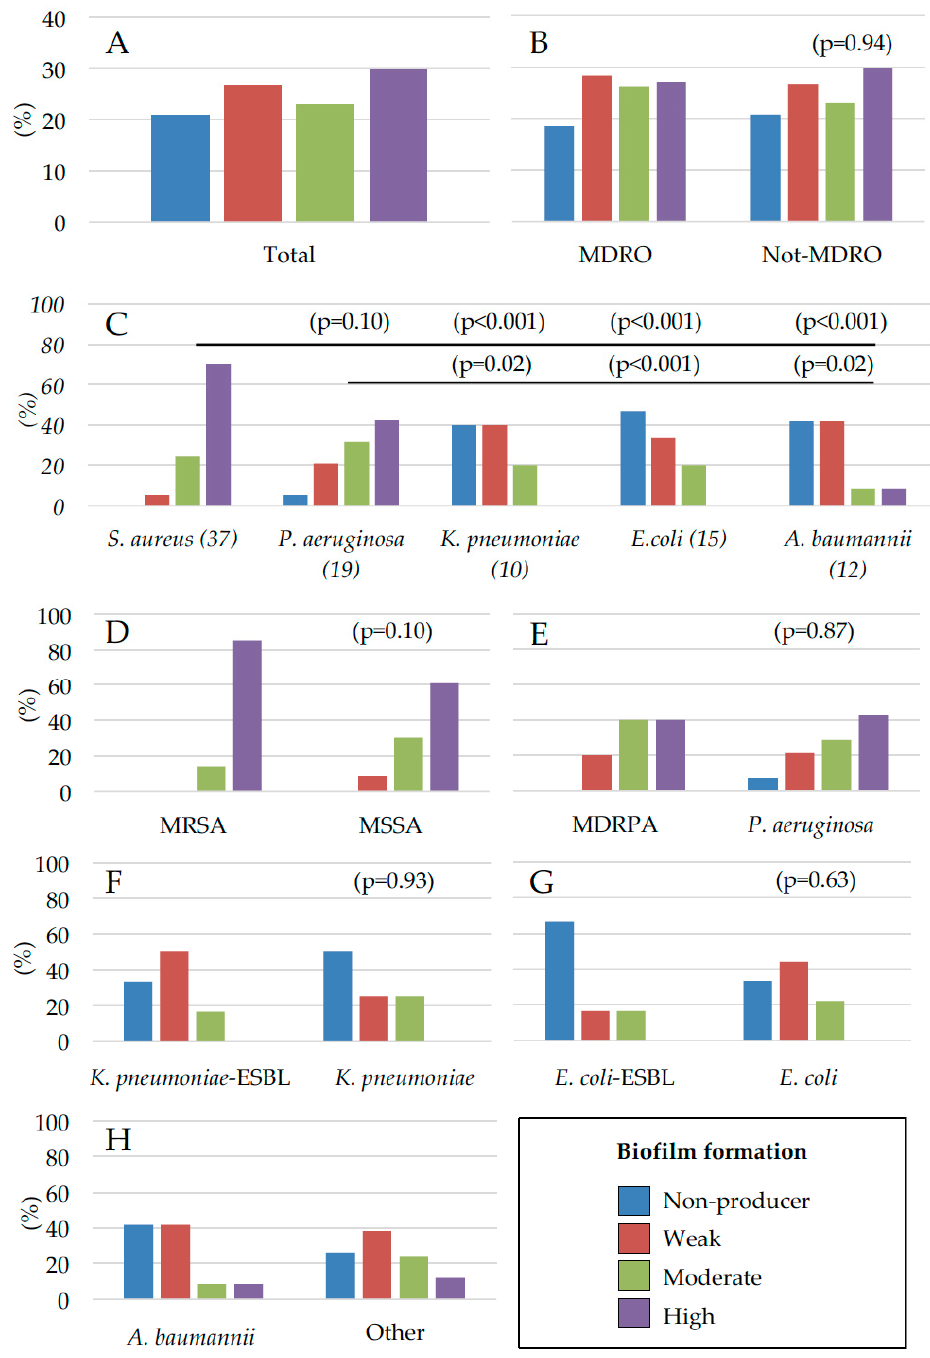
Figure 3. Biofilm production of bacterial isolates from patients with chronic skin ulcers. ( A ) biofilm production of the total bacterial isolates; ( B ) of MDRO and not-MDRO; ( C ) of the different bacterial species and according to multidrug resistance profile: ( D ) MRSA ( n = 14) vs. MSSA ( n = 23); ( E ) MDRPA ( n = 5) vs. P. aeruginosa ( n = 14); ( F ) K. pneumoniae ESBL ( n = 6) vs. K. pneumoniae ( n = 4), E. coli ESBL ( n = 6) vs. E. coli ( n = 9), and A. baumannii ( n = 12) compared with the rest of isolates ( n = 42). Biofilm formation was assessed by the cBRT and clinical isolates were classified as non-producers, weak, moderate and high biofilm producers. All results expressed as percentage of strains with the specific biofilm-forming ability.